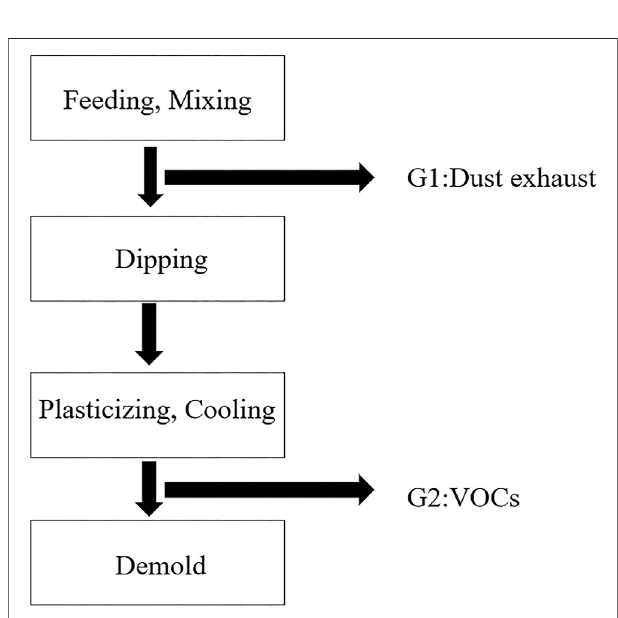
FIGURE 10 | PVC glove production